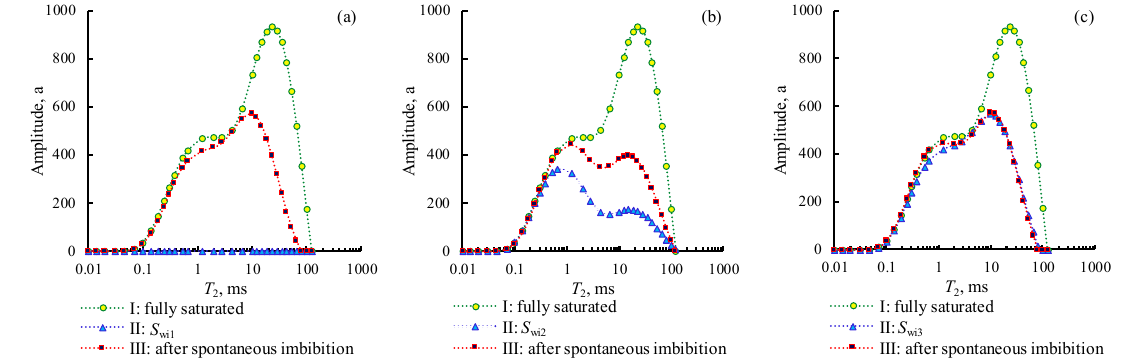
Figure 3. The T 2 spectrum of sample #1-1F that measured in the spontaneous experiments with three S wi : ( a ) S wi1 = 0; ( b ) S wi2 = 39.34 ± 1.57%; ( c ) S wi3 = 62.98 ±